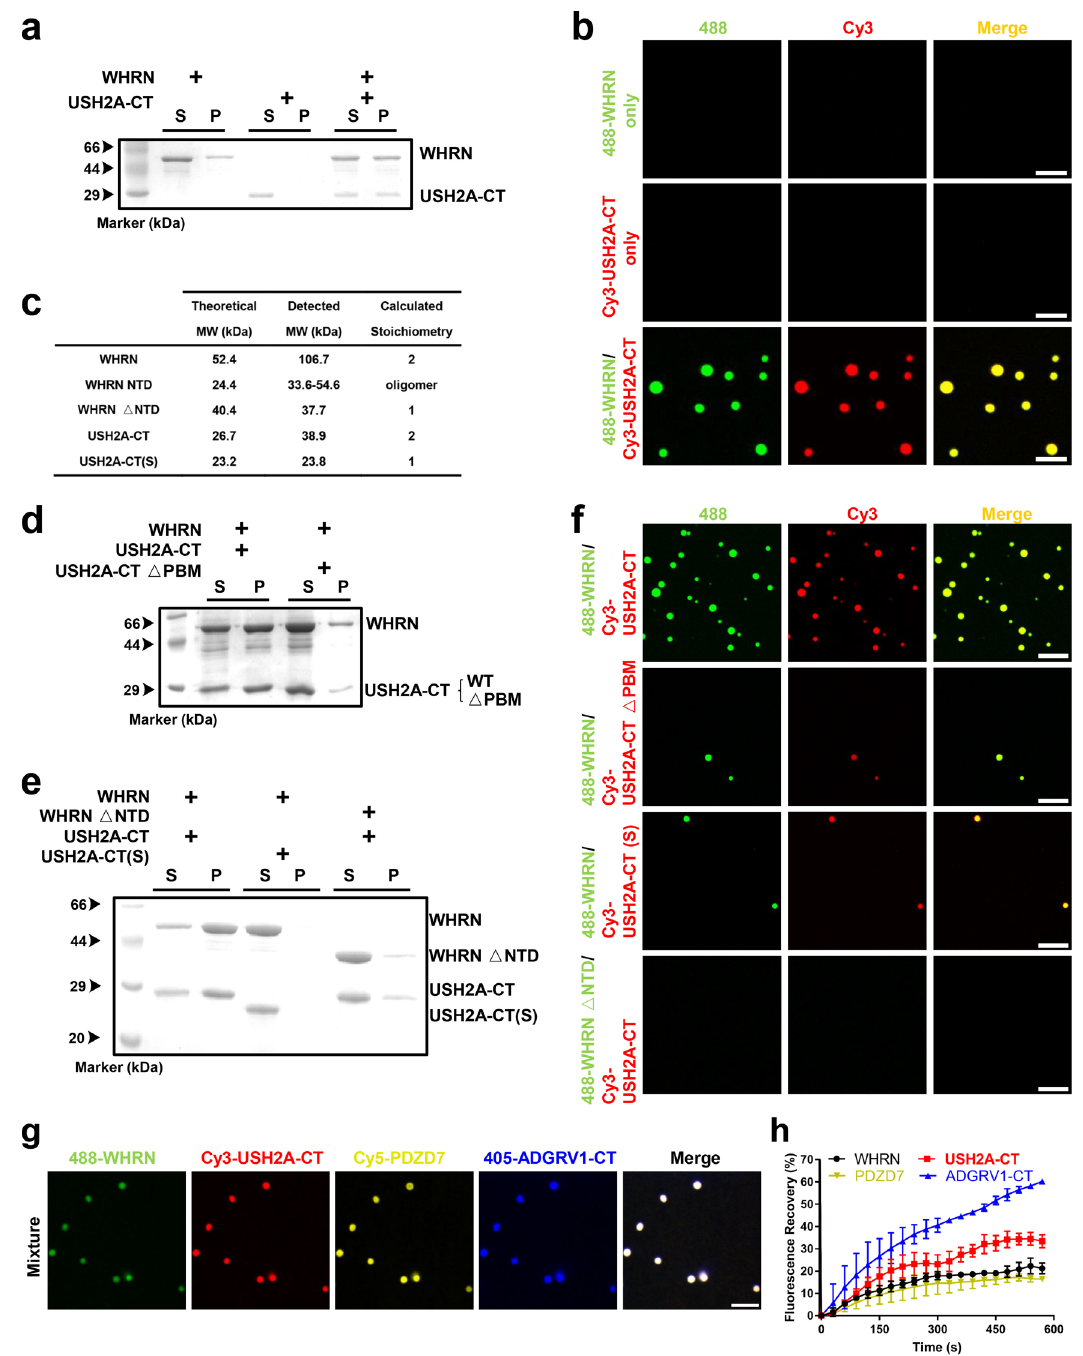
Fig. 5 | Liquid-Liquid Phase Separation (LLPS) of quaternary USH2 protein condensate. a Co-sedimentation-based assay showing that proteins were much more enriched in the pellet in WHRN/USH2A-CT than the isolated group. b Fluorescence images showing that droplets formed in WHRN/USH2A-CT but not theisolatedgroup(20 μ Meach).WHRNandUSH2A-CTwerelabeledwithAlexa488 andCy3,respectively.Labeledproteinswereaddedataratioof1%.Scalebar:5 μ m. c Summaries of the stoichiometry of WHRN, WHRN NTD, WHRN △ NTD, USH2A- CT, or USH2A-CT(S). d Co-sedimentation-based assay showing that the pellet enrichmentsofthetwoproteinsinWHRN/USH2A-CTweredeceasedwhenUSH2A- CT △ PBMwasintroduced.Proteinsweremixedatthe fi nalconcentrationof20 μ M each. e Co-sedimentation-based assays showed that the pellet enrichments of the two proteins in WHRN/USH2A-CT were decreased when WHRN △ NTD or USH2A- CT(S) was introduced. Proteins were mixed at the fi nal concentration of 20 μ M